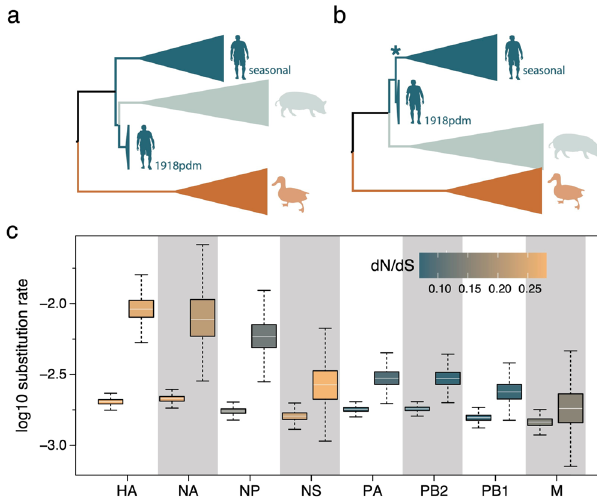
Fig. 4 Time-measured phylogenetic patterns and evolutionary rates estimated using Bayesian molecular clock modeling. a The phylogenetic pattern for HA and NA inferred using a standard host-speci fi c local clock (HSLC) model. b A monophyletic cluster for human pandemic and seasonal viruses estimated for HA and NA using an extended HSLC model (and using either model for all other segments). The star denotes the branch that is allowed to have a separate evolutionary rate in the HSLCext model. c Evolutionary rate estimates for the human lineage ( fi rst box) and the seasonal ancestral branch (second box) under the extended HSLC model for each segment ordered according to difference in these two rates. The boxes are colored according to the dN/dS estimate for the human lineage and the seasonal ancestral branch in each segment. The horizontal line in the whisker plots represents the mean. The lower and upper bounds of the boxes indicate the fi rst and third quartile, respectively. Vertical lines are the upper and lower whisker representing the minimum of the largest value and 1.5 times the inter quartile distance, respectively the maximum of the smallest value and 1.5 times the inter quartile distance. Sample size from the MCMC chain is 2702 for NA and 4502 for all other segments. Source data are provided as a Source Data fi